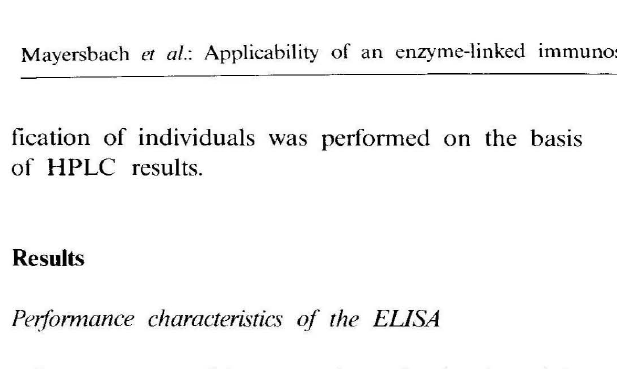
Table 1. Concentrations of neopterin in sera from 1040 blood donors, detennined by ELISA and RIA.